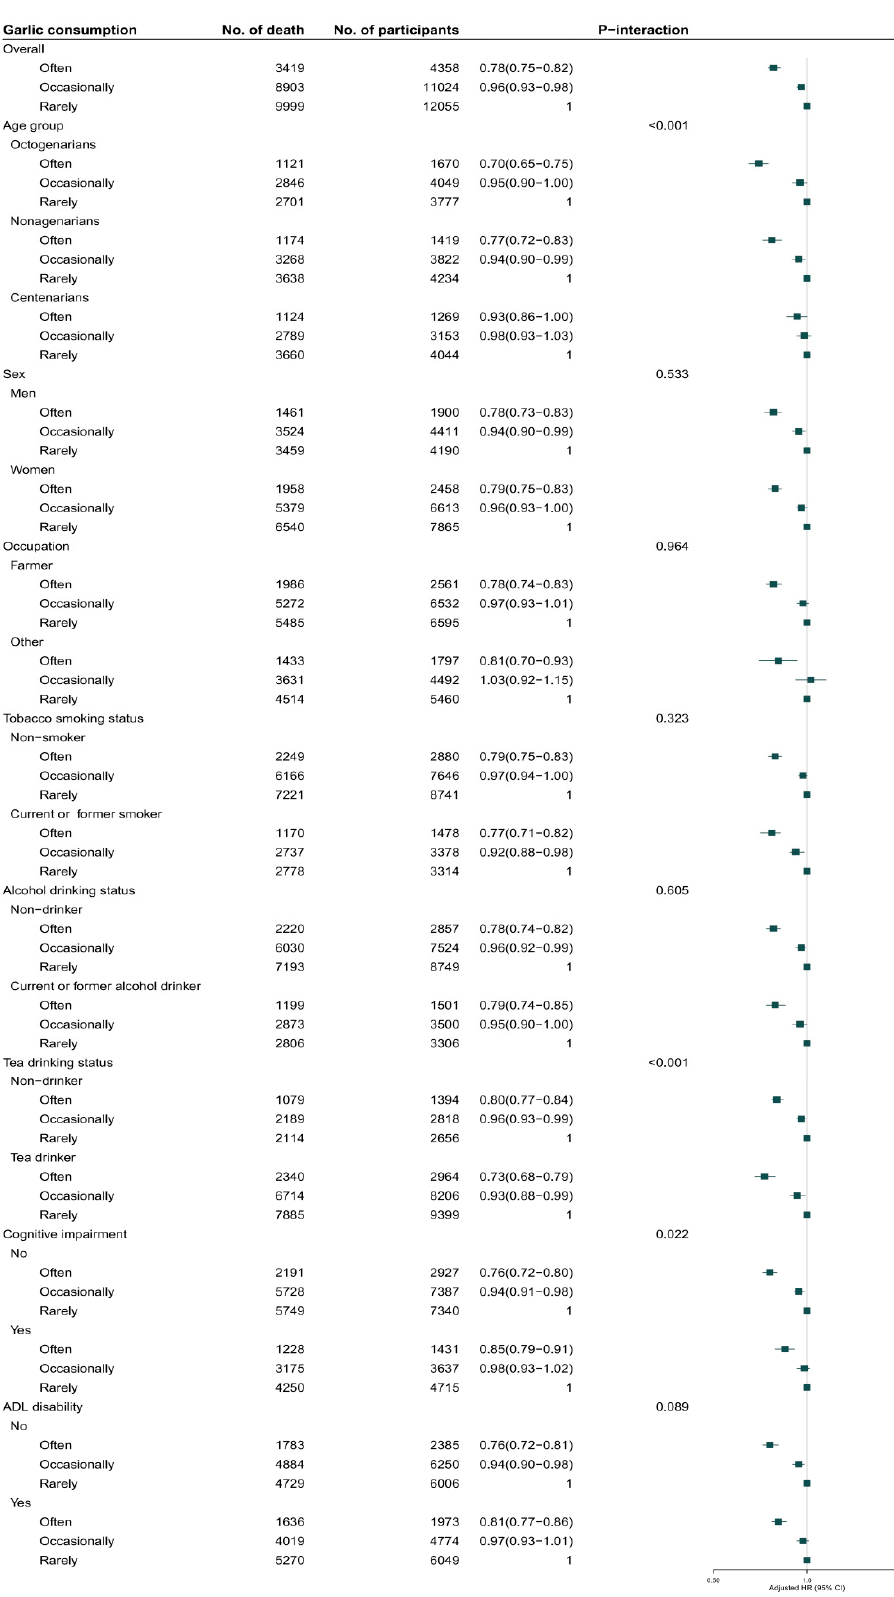
Figure 3. Association of garlic consumption at age 60 with all-cause mortality in the oldest old. Adjusted for age, sex, BMI, residence, educational background, occupation, current marital status, living pattern, tobacco smoking, alcohol drinking, regular exercise, eating vegetables, eating fruits, meat, and fish, drinking tea, hypertension, heart disease, cerebrovascular disease, respiratory disease, cognitive impairment, and ADL disability.